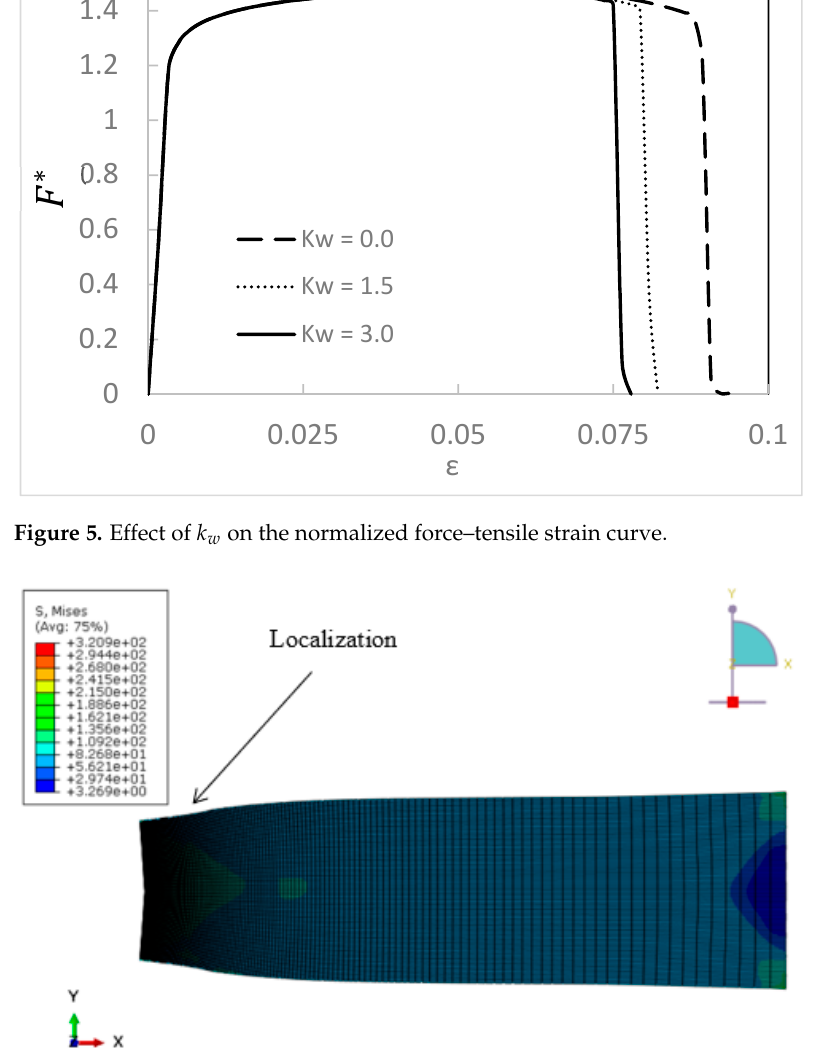
Figure 6. Deformed shape of the specimen after fracture.